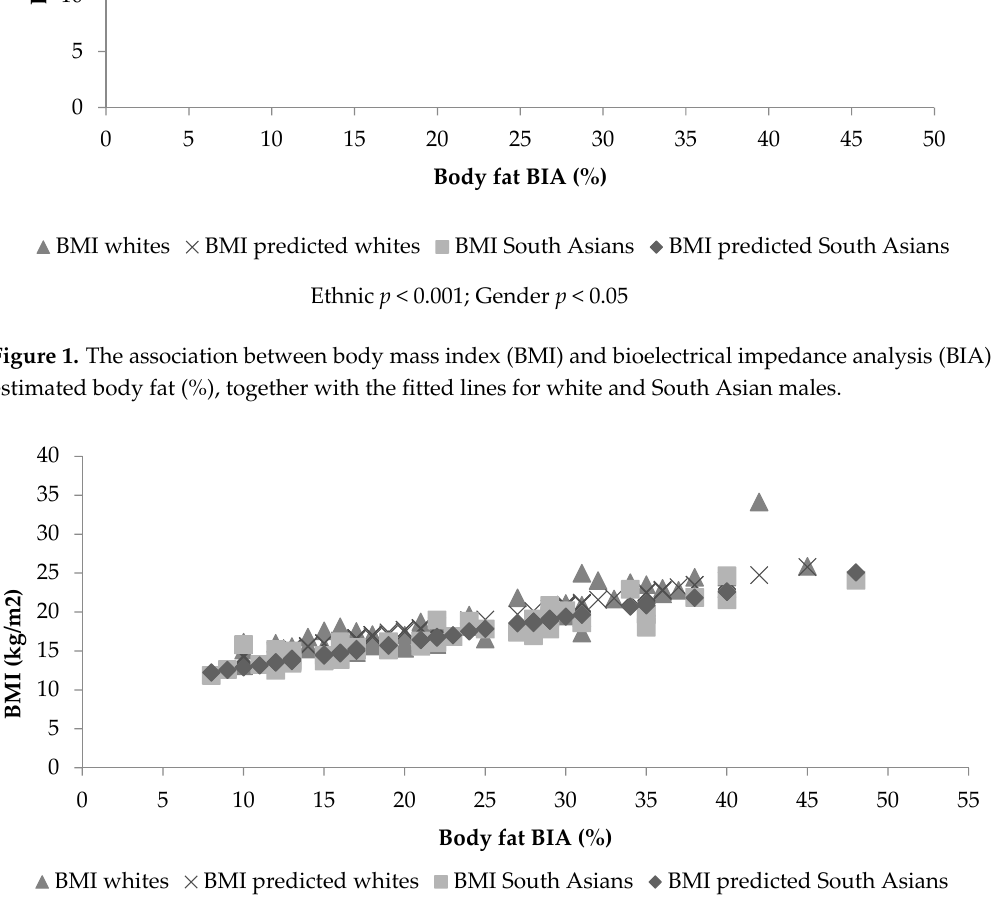
Figure 2. The association between BMI and BIA estimated body fat (%), together with the fitted lines for white and South Asian females.